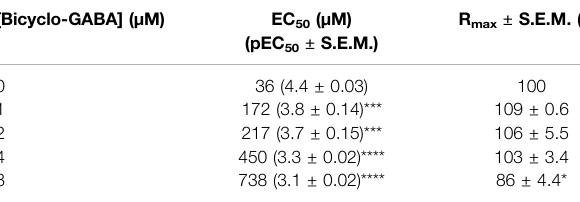
TABLE1| Theeffectofincreasingconcentrationsoftheinhibitorbicyclo-GABAon the GABA EC 50 and R max at BGT1 measured in the FMP assay. The GABA EC 50 andR max valuesarecomparedtothecorrespondingvaluesintheabsenceof bicyclo-GABA by a One-way ANOVA followed by Dunnett ’ s multiple